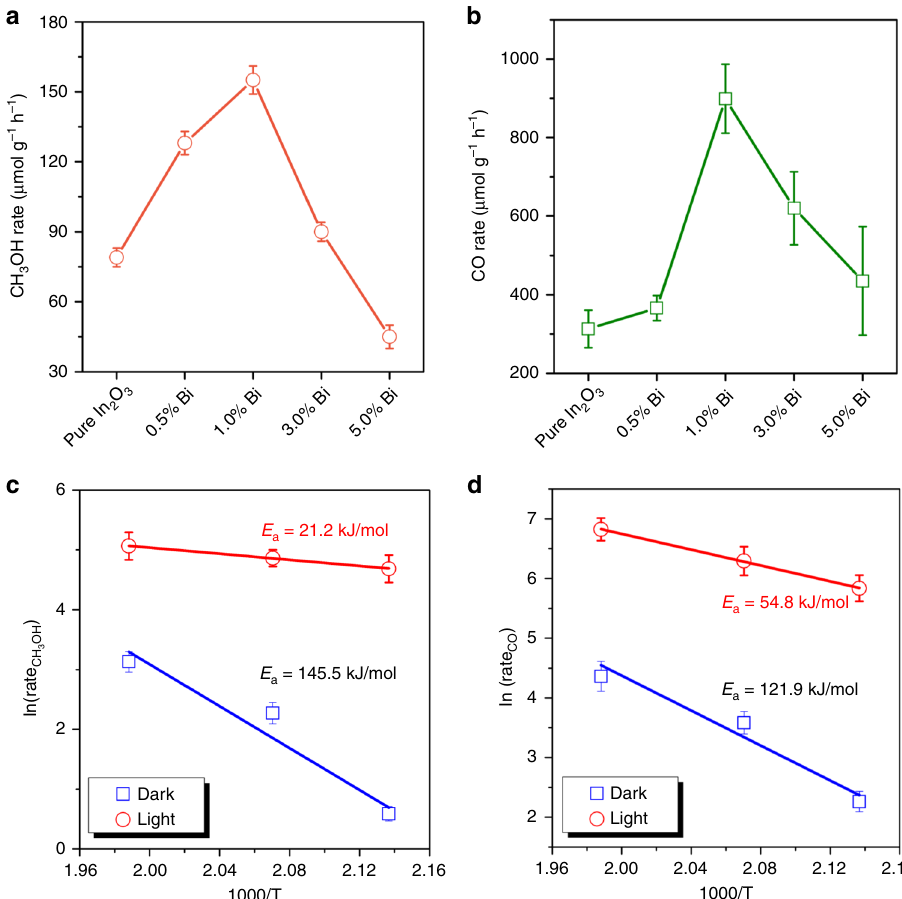
Fig. 3 Catalytic performance in the fl ow reactor with and without light irradiation. a CH 3 OH production rates as a function of Bi 3 + content under light irradiation and at 230 °C. b CO production rates as a function of Bi 3 + content under light irradiation and at 230 °C. c Arrhenius plots for CH 3 OH production rates of 1.0% Bi x In 2 – x O 3 with and without solar irradiation. d Arrhenius plots for CO production rates of 1.0% Bi x In 2 – x O 3 with and without solar